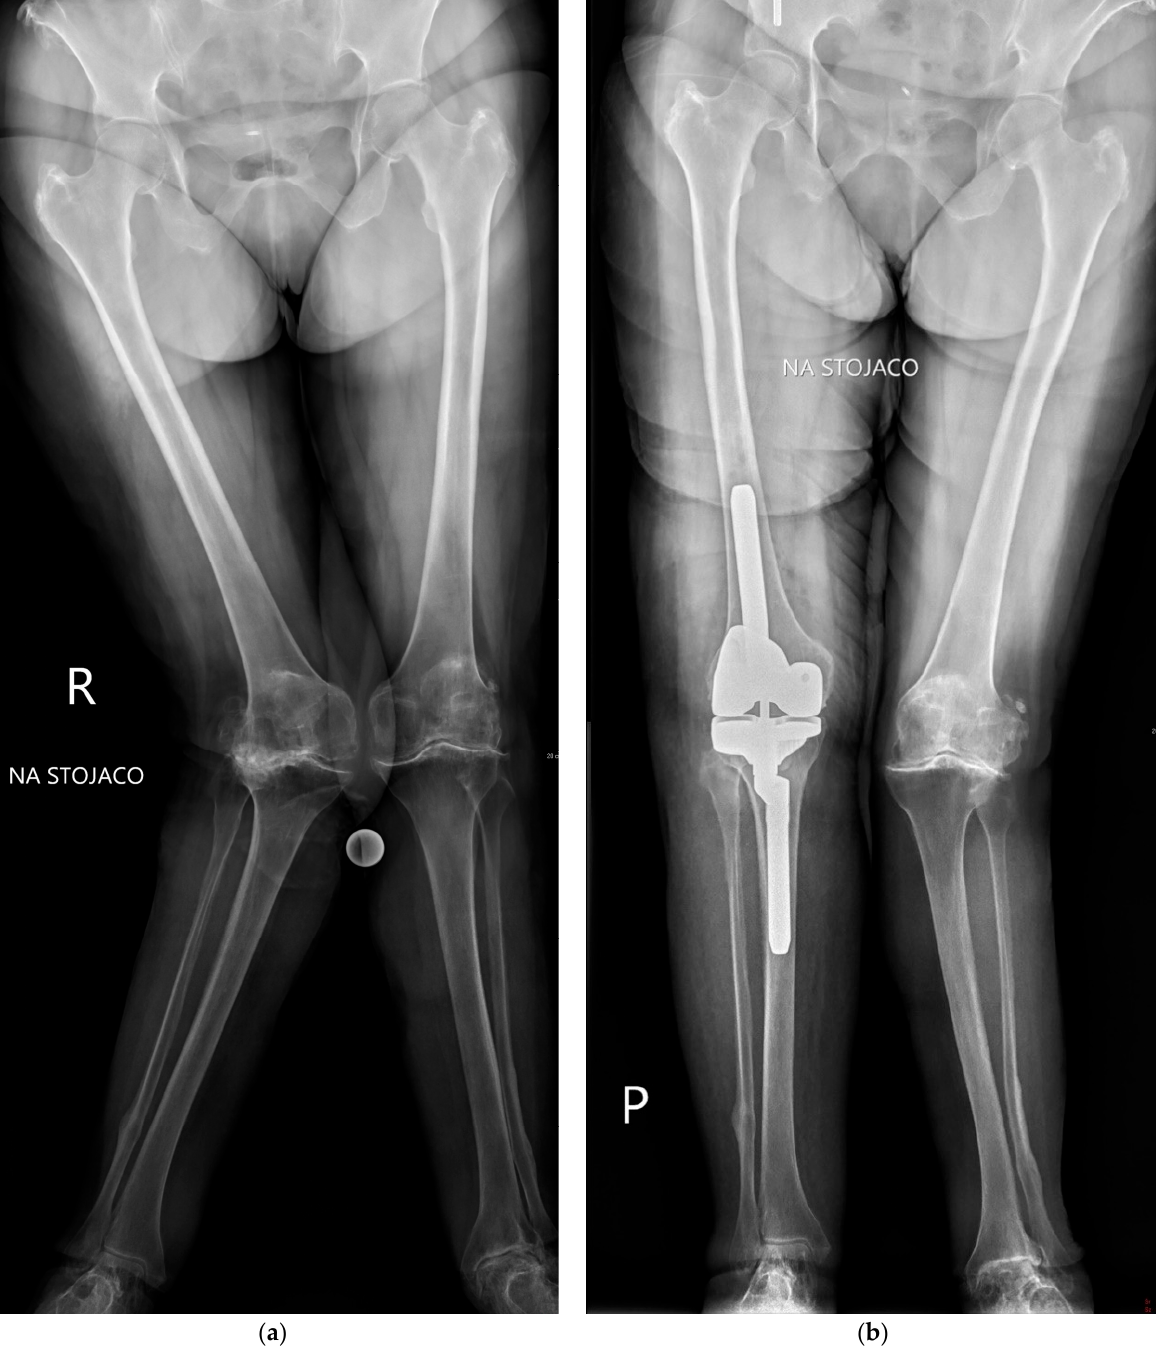
Figure 1. ( a ) Patient with grade III fixed valgus deformity’s long-standing X-ray. ( b ) Postoperative x-ray with mechanical axis